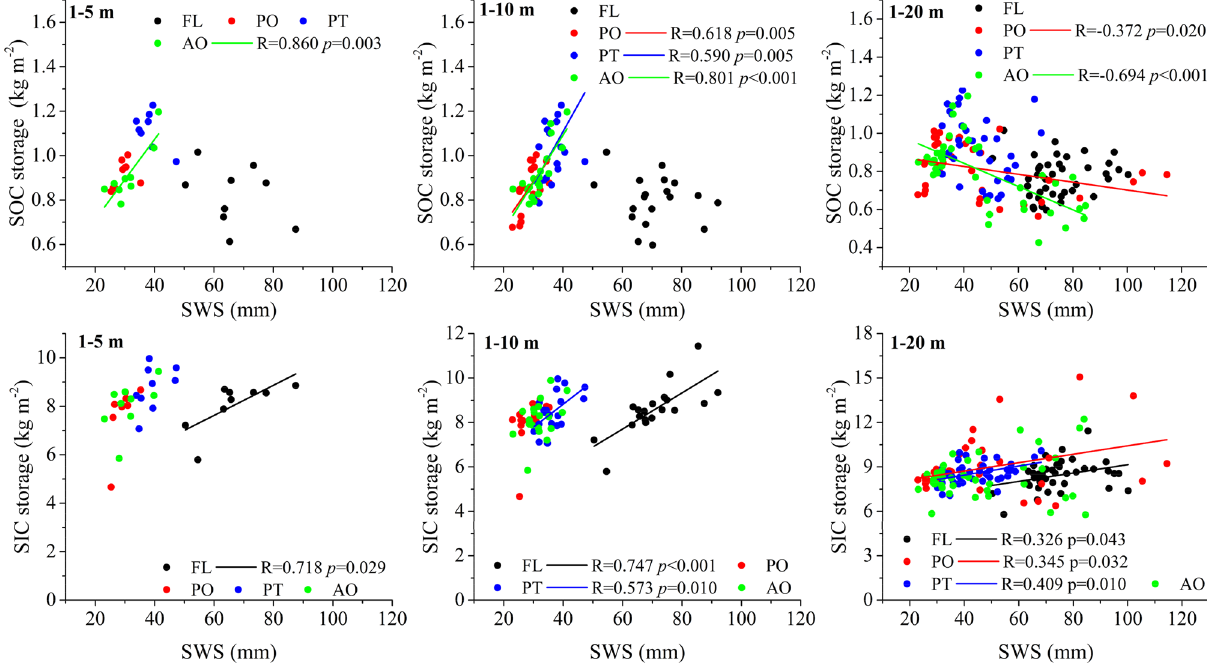
Figure 6. Relationships between SOC storage and SWS, SIC storage and SWS in the 1–5 m, 1–10 m and 1–20 m soil layers for different vegetation types. FL farmland, PO Platycladus orientalis (Linn.) Franco, PT Pinus tabulaeformis Carr., AO apple orchard.The only regression lines with statistical significance ( p < 0.05) were drawn in the figure.